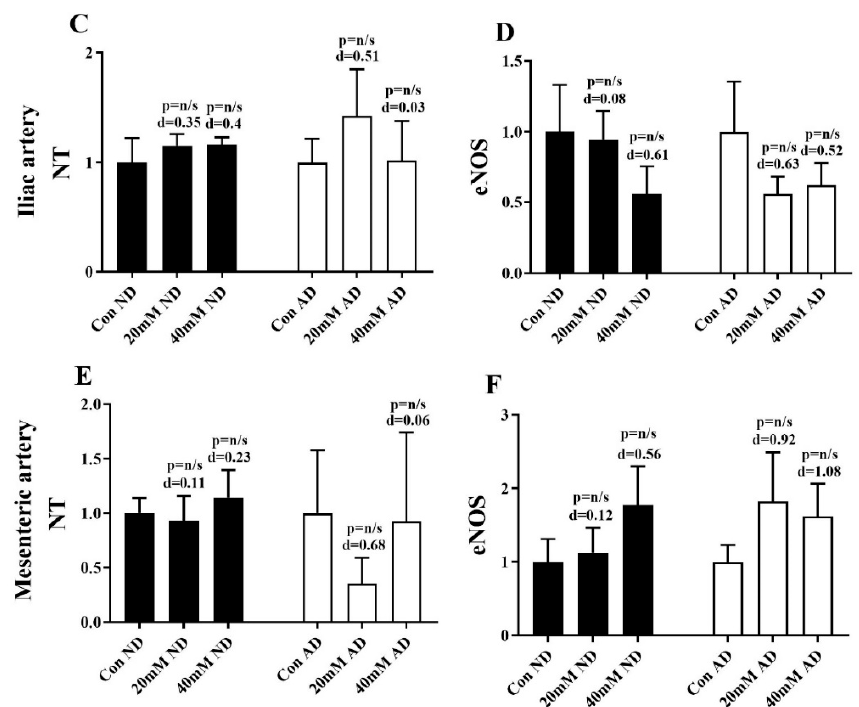
Figure 4. Immunoreactivity of NT and eNOS in abdominal aorta ( A , B ), iliac artery ( C , D ), and mesenteric artery ( E , F ). Immunoreactivity is calculated based on the intensity of the staining present on the endothelium, which is an arbitrary unit and expressed as fold change from the respective control. Numbers above columns represent the statistical significance ( p ) and effect size ( d ) in comparison to the control group for each diet. ^ p 0.05–0.99 vs. control. Con: normal Krebs; 20 mM: 20 mM glucose Krebs; 40 mM: 40 mM glucose Krebs; ND: normal diet; AD: atherogenic diet; NT: nitrotyrosine; eNOS: endothelial nitric oxide synthase.